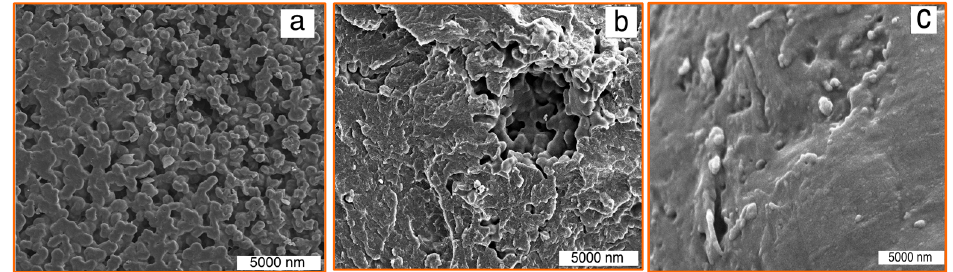
Figure 7. SEM pictures of different composites: ( a ) CNS/PP; ( b ) CNS-FLG/PP and ( c ) CNS-MLG/PP.